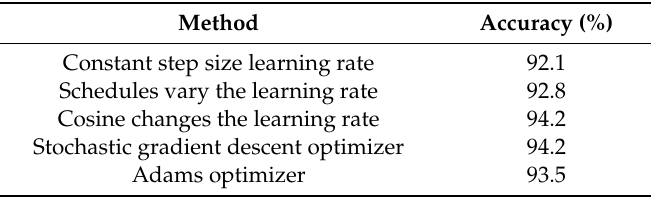
Figure 14. Because distortion mapping and up-sampling are processes that go from coarse to fine, the varying learning rate had a better convergence e ff ect on our system. ( a ) The learning rate of cosine decay is used. ( b ) Constant learning rate. Table 6. The e ff ects of di ff erent training